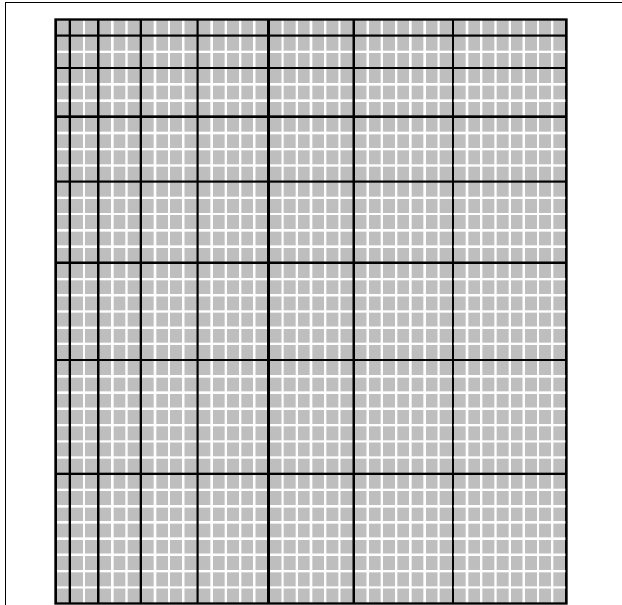
FIGURE 1 | Laisant’s table [adapted from Maffia and Mariotti (2020)]. Each black-framed rectangle represents a multiplication—that of its width in little squares by its height in little squares. The outcome of this multiplication equals the total number of little squares contained within the black-framed rectangle. In the present example, the upper-left black-framed rectangle represents the multiplication 1 × 1, the lower-right one 8 × 8. Now consider, say, the multiplications of 2 × 3, 2 × 4, and 2 × 7. Count the number of little squares inside the black-framed rectangles that correspond to each of these multiplications and note that—as per the distributive law of multiplication—(2 × 3)+(2 × 4) = 2 × 7.